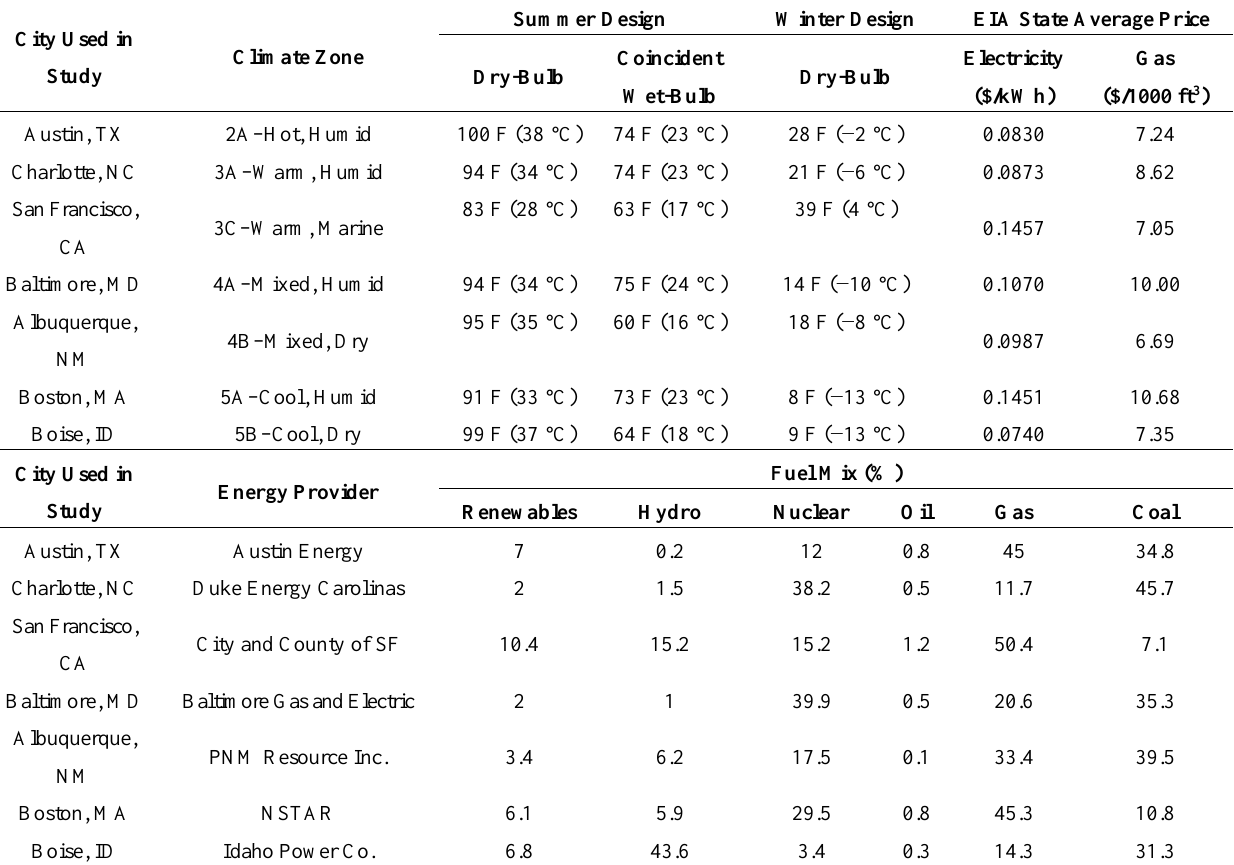
Table 1. Climate and fuel costs used for model inputs. Electricity generation fuel mix used for environmental impact